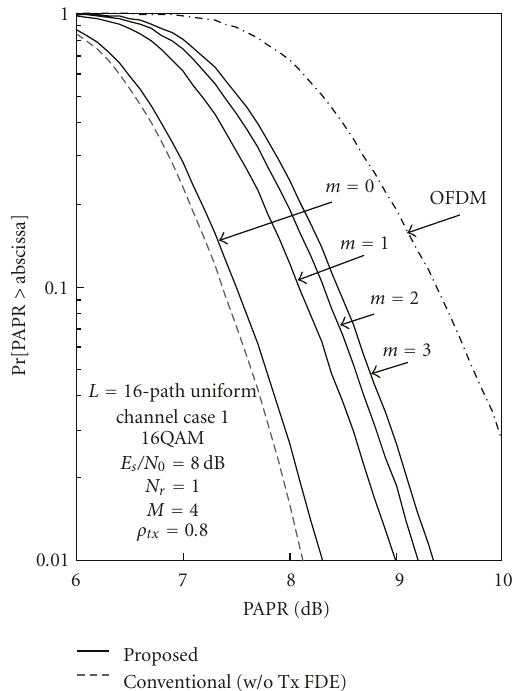
Figure 10: PAPR distribution with the average transmit E s /N 0 as a parameter.